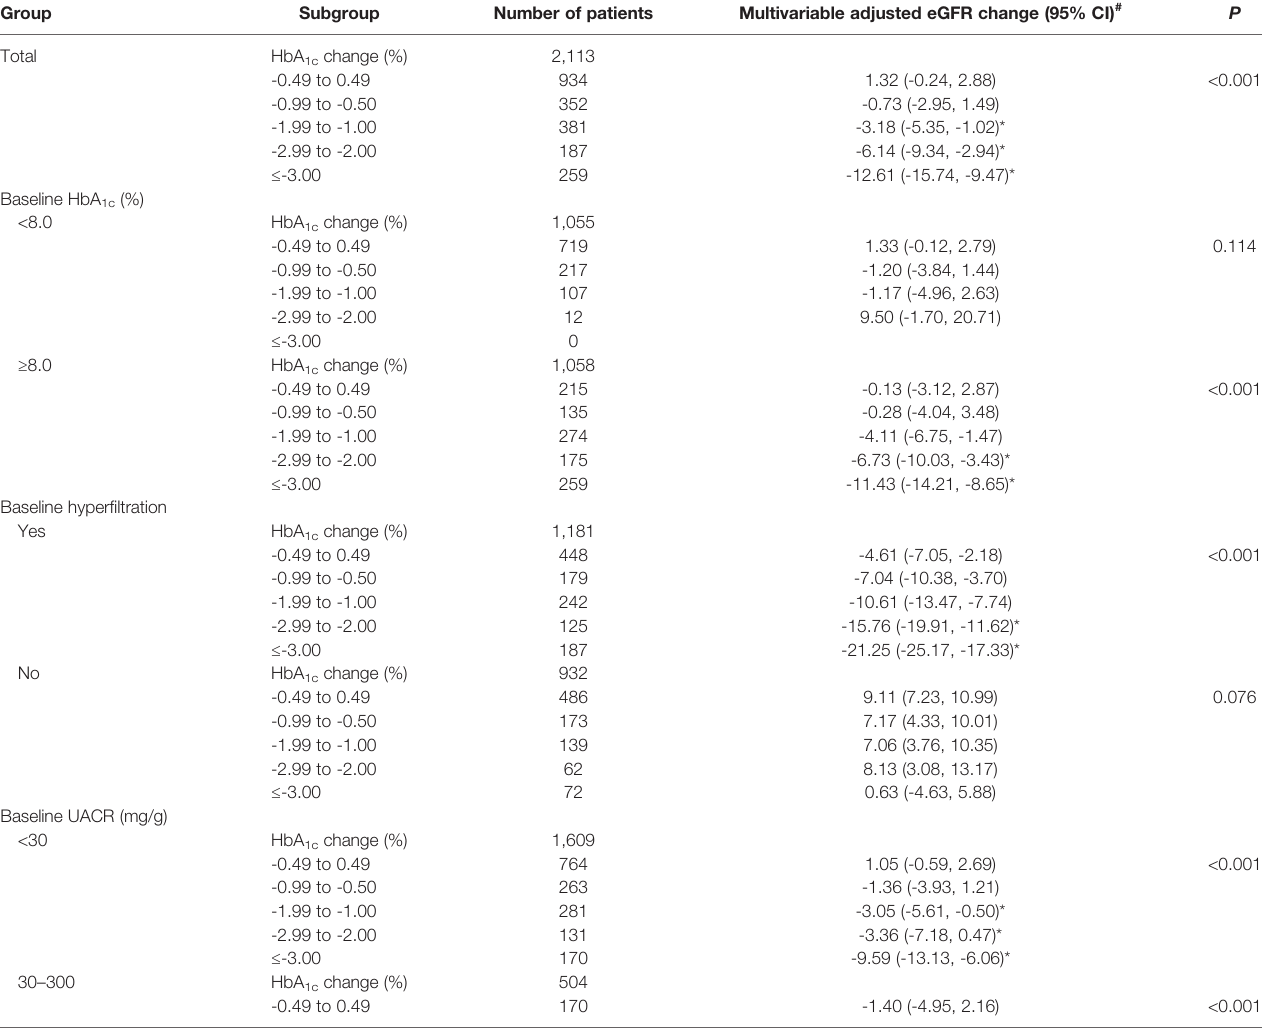
TABLE 4 | Comparison of mean eGFR change in the different HbA 1c decrease groups.